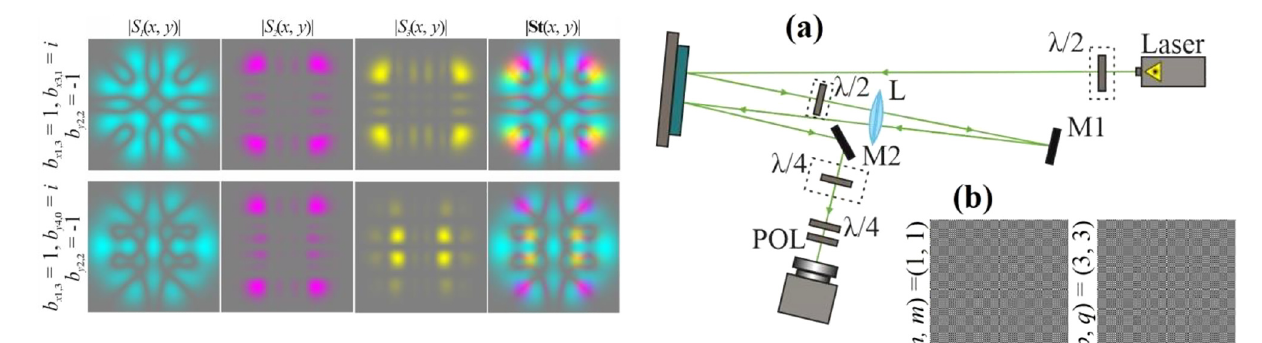
Figure 8: Distribution of the Stokes vector defined by Eq. (24) for inhomogeneously polarized beams presented in Figure 7. To generate HG vector modes, the transverse compo- nents of the input electromagnetic field should contain HG modes with indices whose sum is the same. For the visual analysis of the polarization state of inhomogeneously polarized beams, we use the transverse distribution of the vector of three Stokes parameters. Moreover, the corre- spondence of the third Stokes parameter to the distribution of the longitudinal component of the SAM is used for experimental measurements.